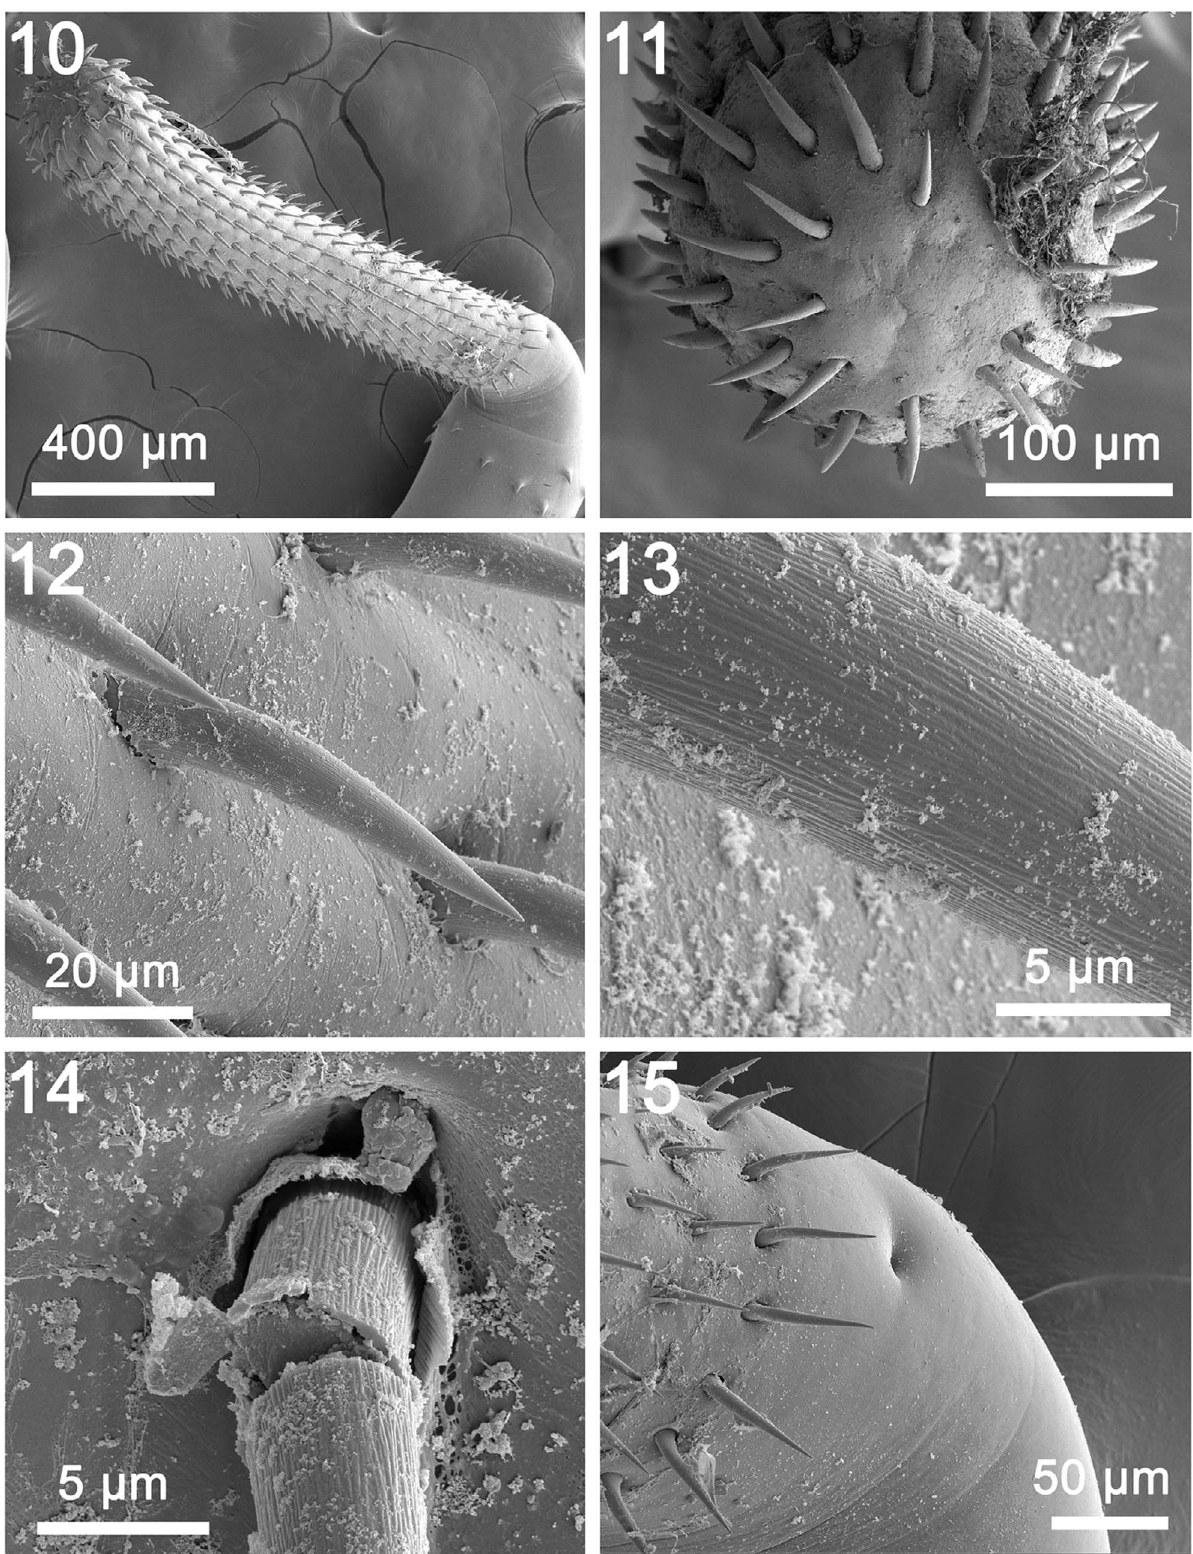
Figures 10 – 15. SEM of specimens of Rhadinorhynchus laterospinosus from Auxis rochei and Auxis thazard in the Paci fi c Ocean off Vietnam. (10) The proboscis of a female specimen. (11) The apical end of the proboscis in Figure 10 showing the smaller apical hooks, the organization of hook rows and no external evidence of an apical organ. (12) A typical example of hook shape and orientation from the midsection of a proboscis. (13) A magni fi ed view of a hook showing its surface serrations. (14) A broken hook demonstrating its thick core and thin cortical layer. (15) Posterior end of a proboscis showing the larger hooks in the posterior circle and a sensory